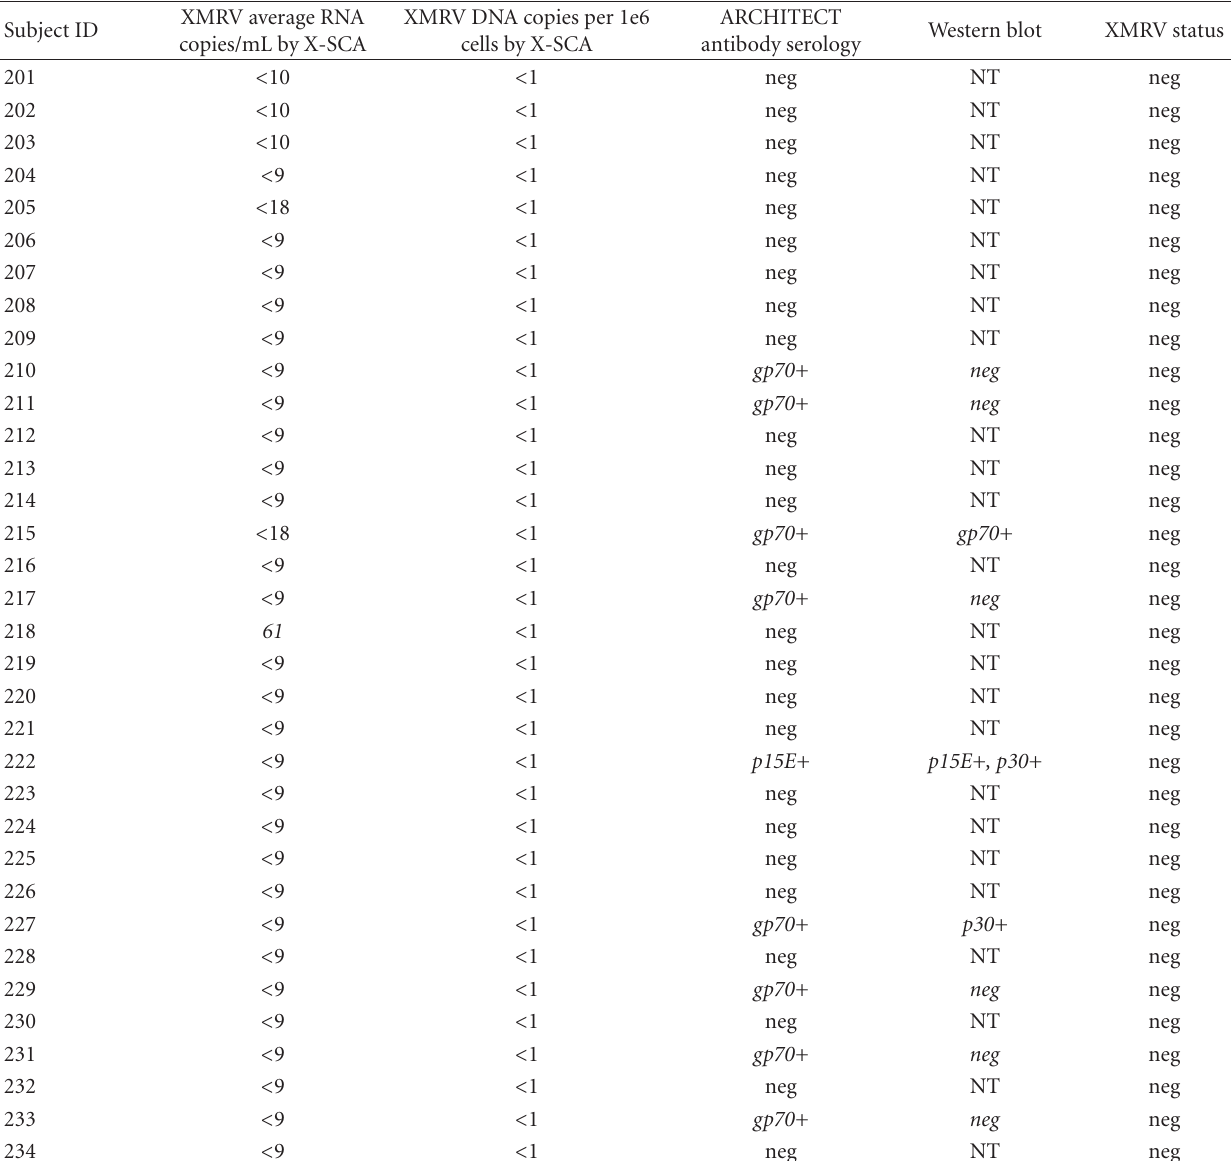
∗ NT indicates that MACS ID was not tested by Western blot